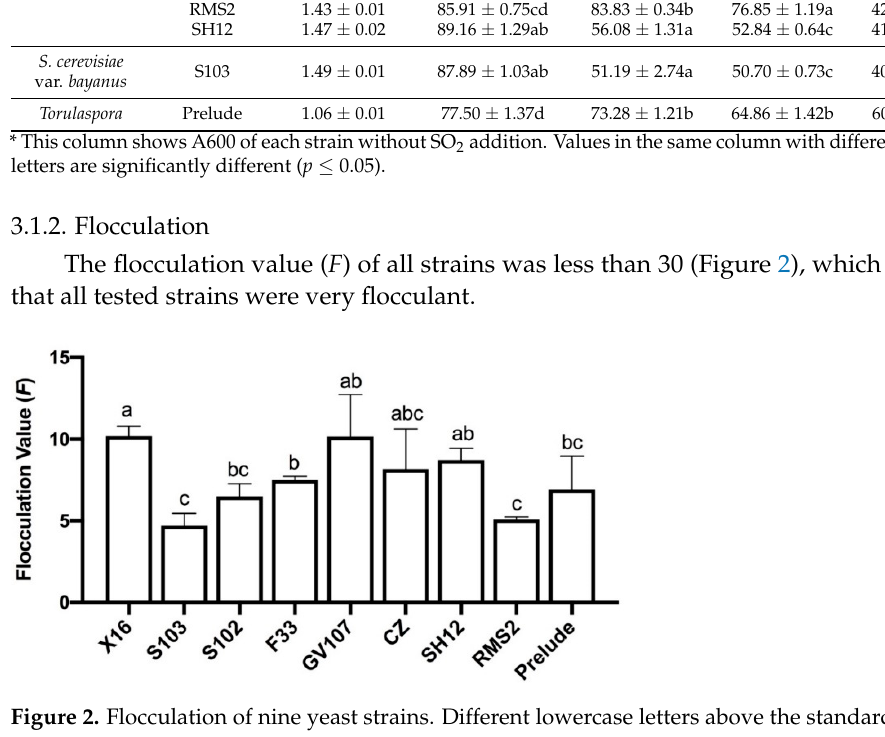
Figure 2. Flocculation of nine yeast strains. Different lowercase letters above the standard deviation bar indicate significant difference ( p ≤ bar indicate significant difference ( p ≤ 0.05).